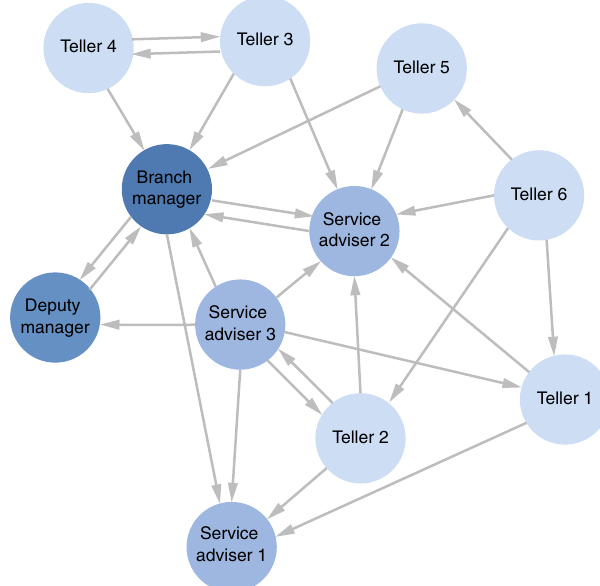
Fig. 7 The network of con fi ding relationship among the 11 agents of the Australian bank dataset 42 . Every link has unitary weight and more important nodes have darker color.